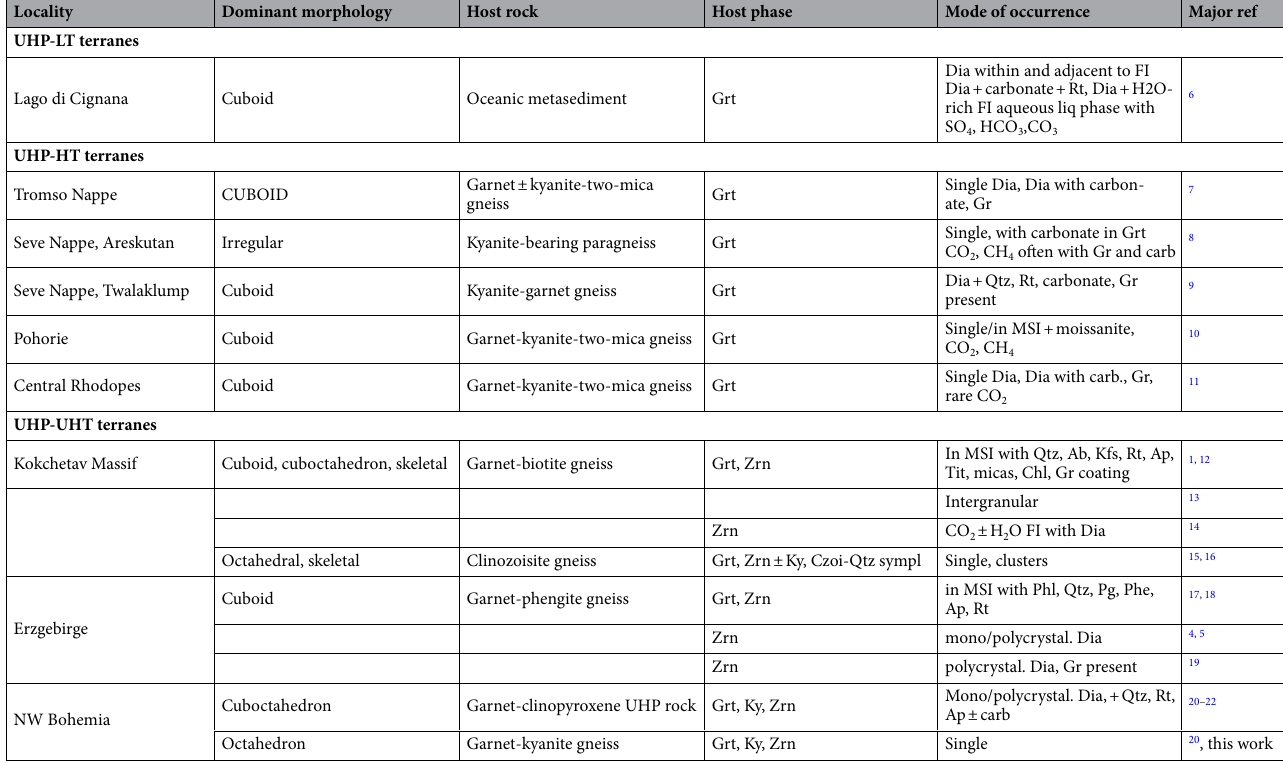
Table 1. Comparison of morphology and mode of occurrence of microdiamonds in metasediments worldwide. Cuboid or cubooctahedron term as used by individual authors. FI fluid inclusion, MSI multiple solid inclusion. Carbonate-bearing rocks from Kokchetav Massif are not